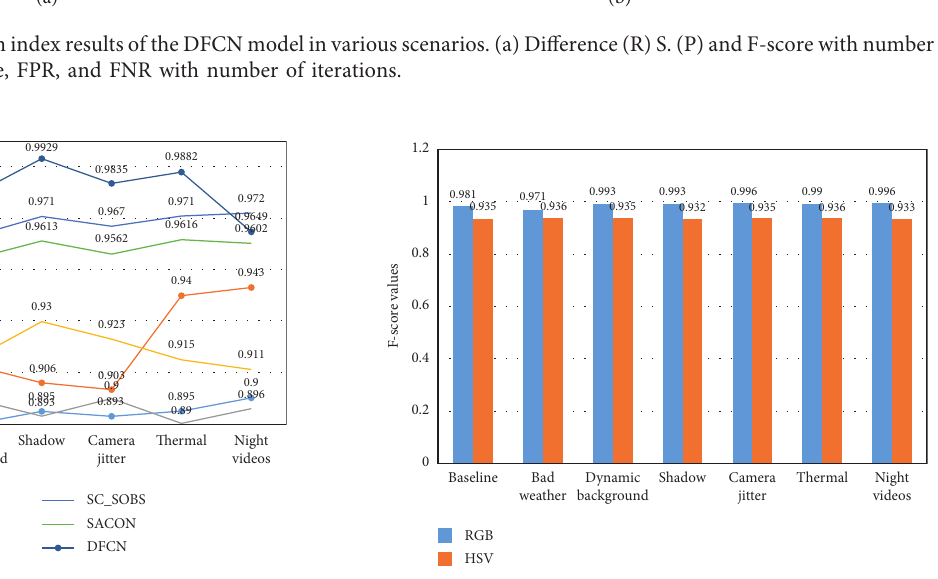
Figure 8: F-score evaluation index results of DFCN model and other algorithms in various scenarios.